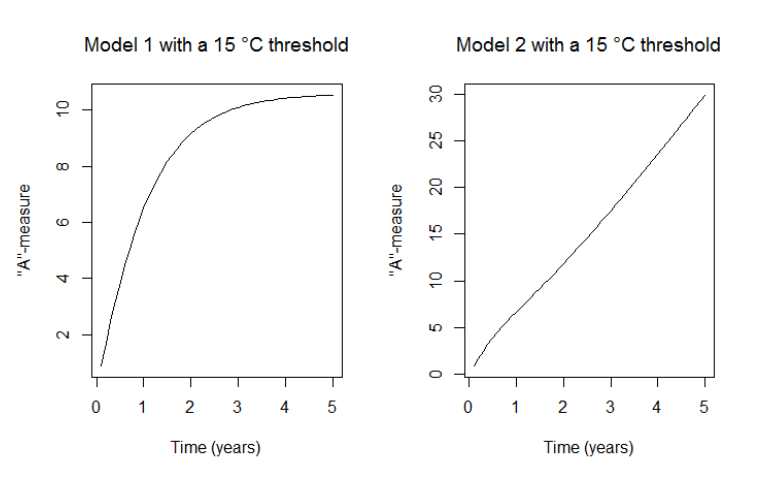
Figure 2. A-measure for both Model 1 Equation (10) and Model 2 Equation (11) with initial temperature equal to 24 ◦ C and threshold equal to 15 ◦ C. A-measure is plotted as a function of the time of maturity (from zero to five